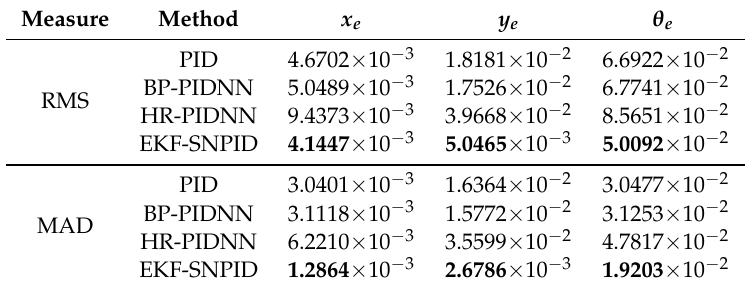
Table 1. Simulation results for the sinusoidal trajectory. The best results are highlighted in